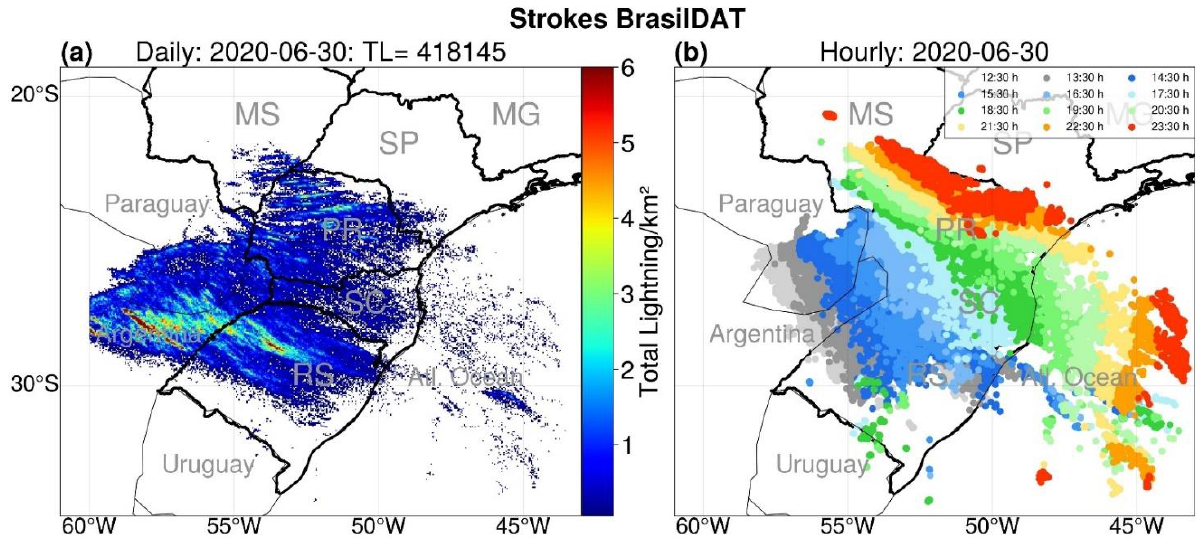
Figure 15. ( a ) Daily total lightning strokes (intracloud plus cloud-to-ground lightning) at a grid spatial resolution of 4 km and ( b ) point lightning strokes for 1 h for 30 June 2020. In Figure ( b ) the light gray color represents the lightning occurrences accumulated between 1230 and 1330 h.